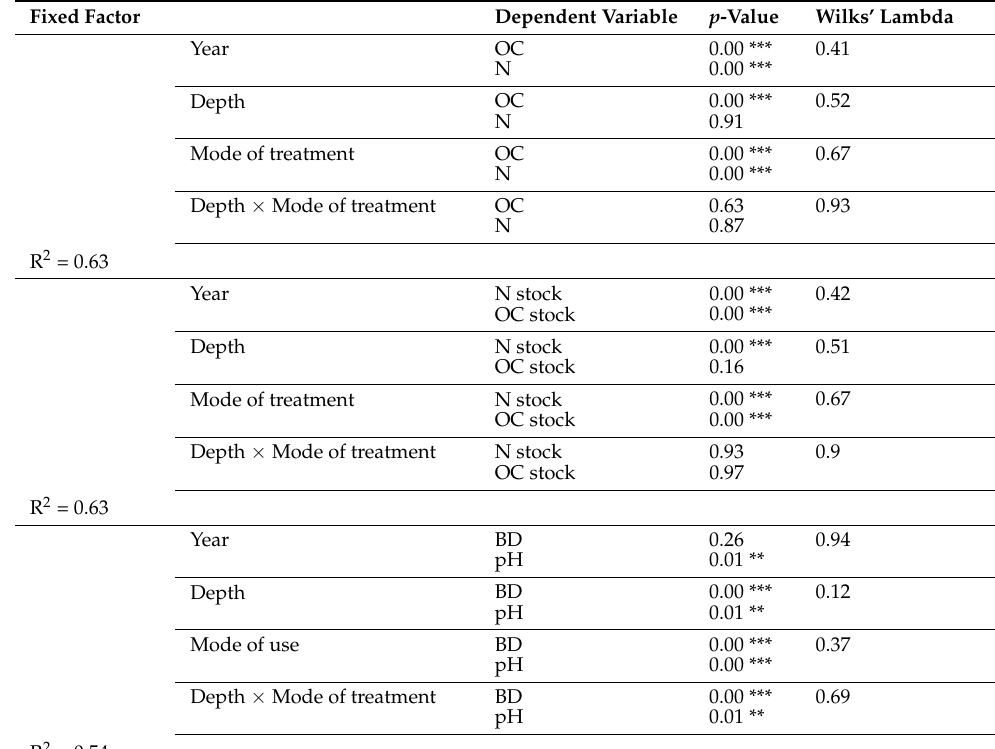
Table 5. ANOVA test for year, depth, and mode of treatment